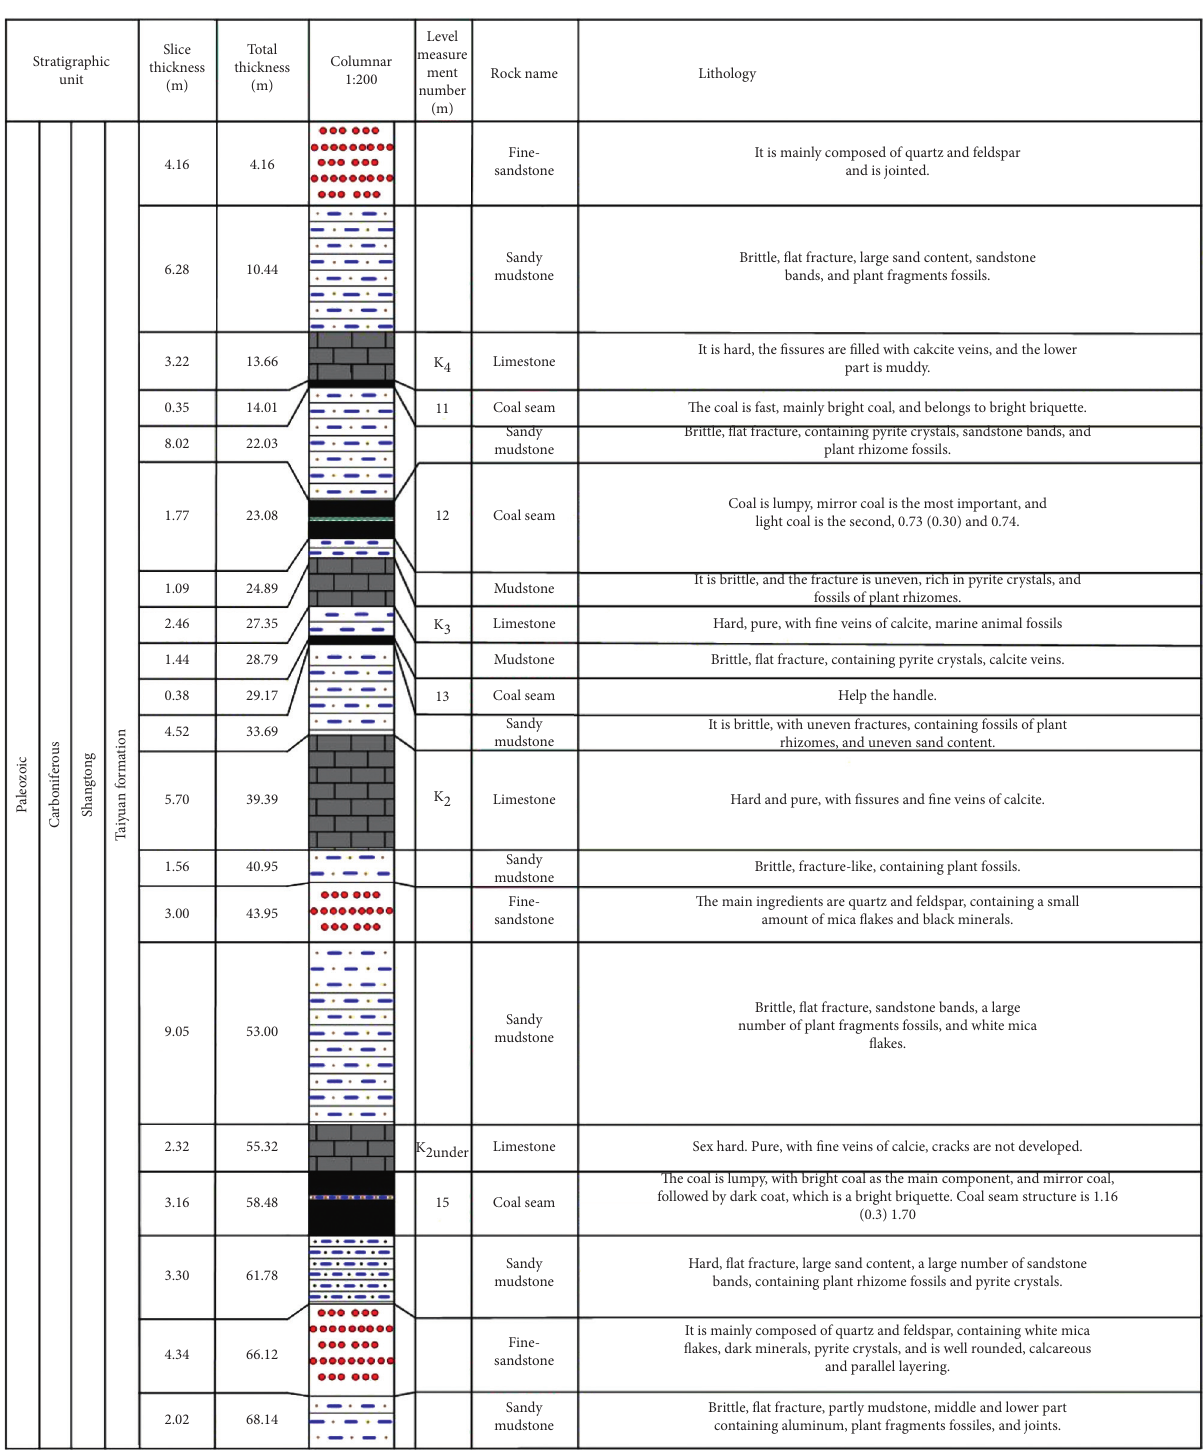
Figure 5: Synthesis column map of 15106 working